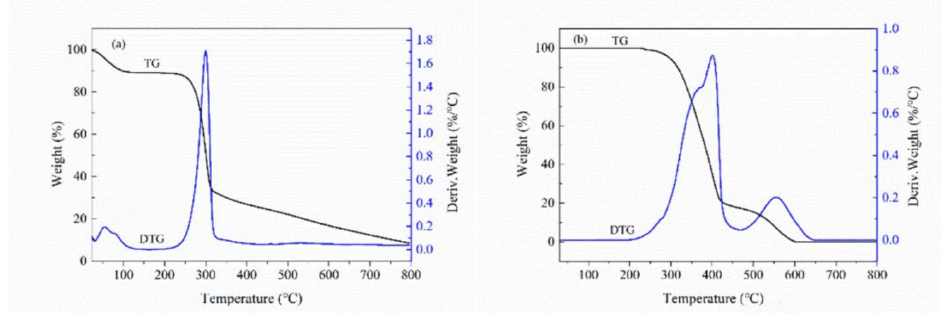
Figure 7. ( a ) DTG curves of BX. ( b ) DTG curves of